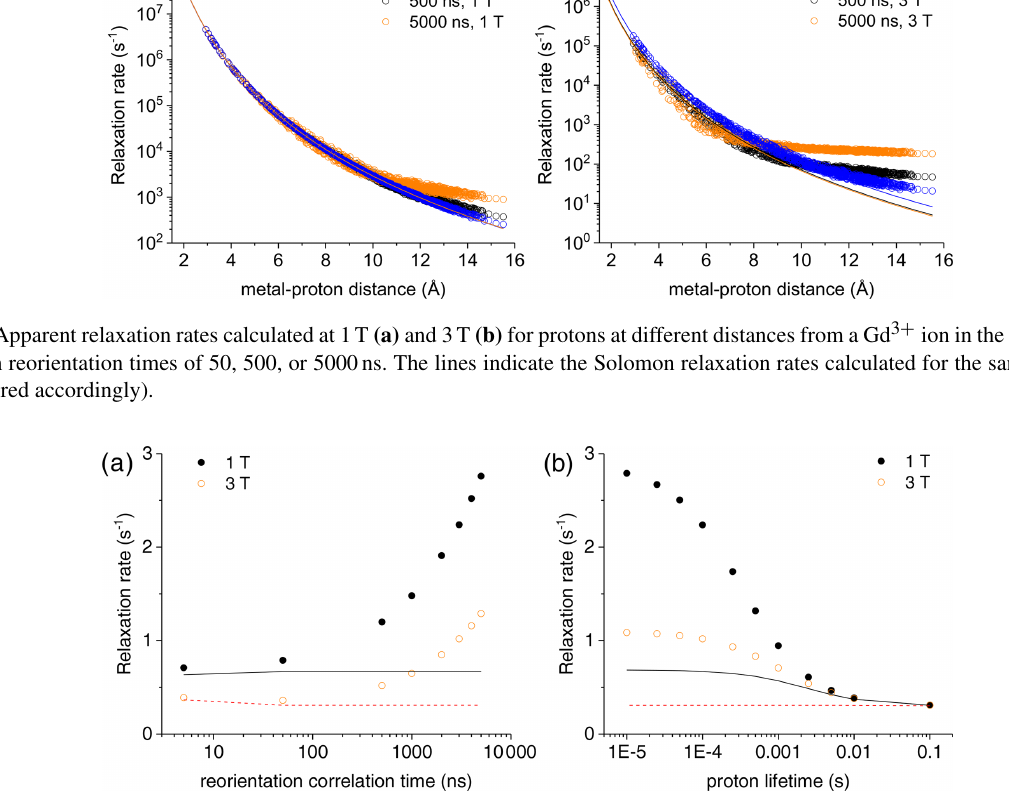
Figure 3. (a) Bulk water proton relaxation rates calculated at 1 and 3T as a function of the reorientation time of the Gd 3 + -containing macromolecular model (at 0.001moldm − 3 concentration), with 100 surface protons with an exchange rate of 0.1ms. (b) Bulk water proton relaxation rates calculated at 1 and 3T as a function of the exchange rate of 100 surface protons in the macromolecular model with a reorientation time of 3000ns. The bulk water proton relaxation rates calculated with the Solomon equation, and according to R 1bulk = (cid:16) (cid:17) − 1 + τ M R 1dia + f R − 1 , at 1 and 3T are shown as solid and dashed lines, respectively. In all calculations, an intrinsic diamagnetic rate of 1 M 0.3s − 1 is